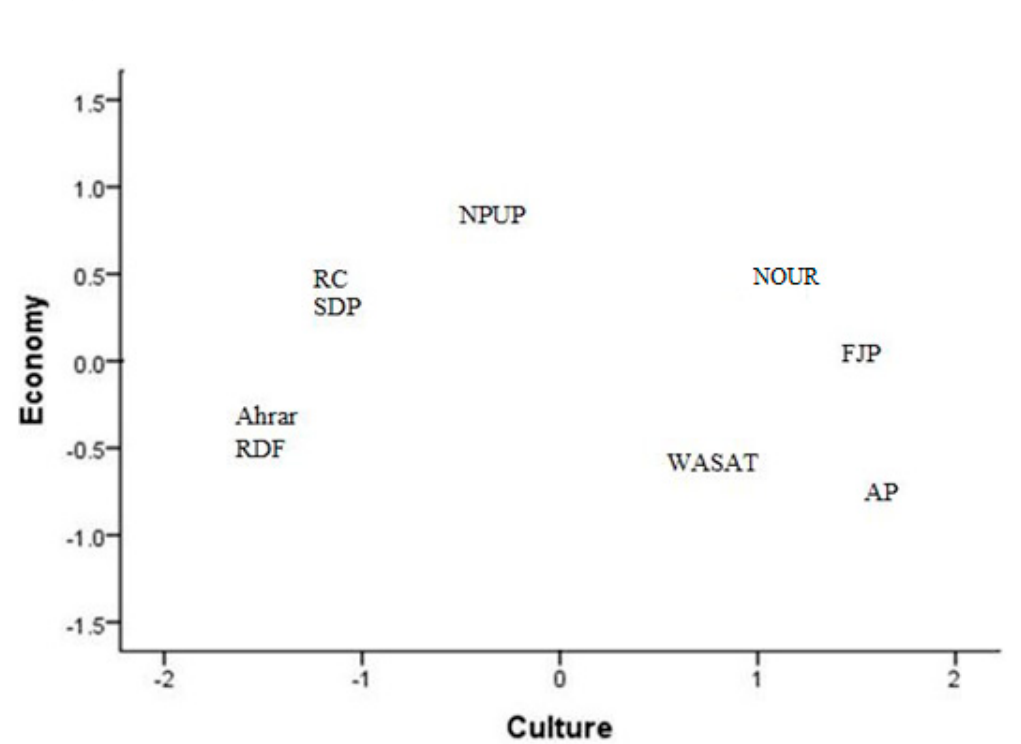
Figure 9. Ideological structure of Egyptian issues, 2011.